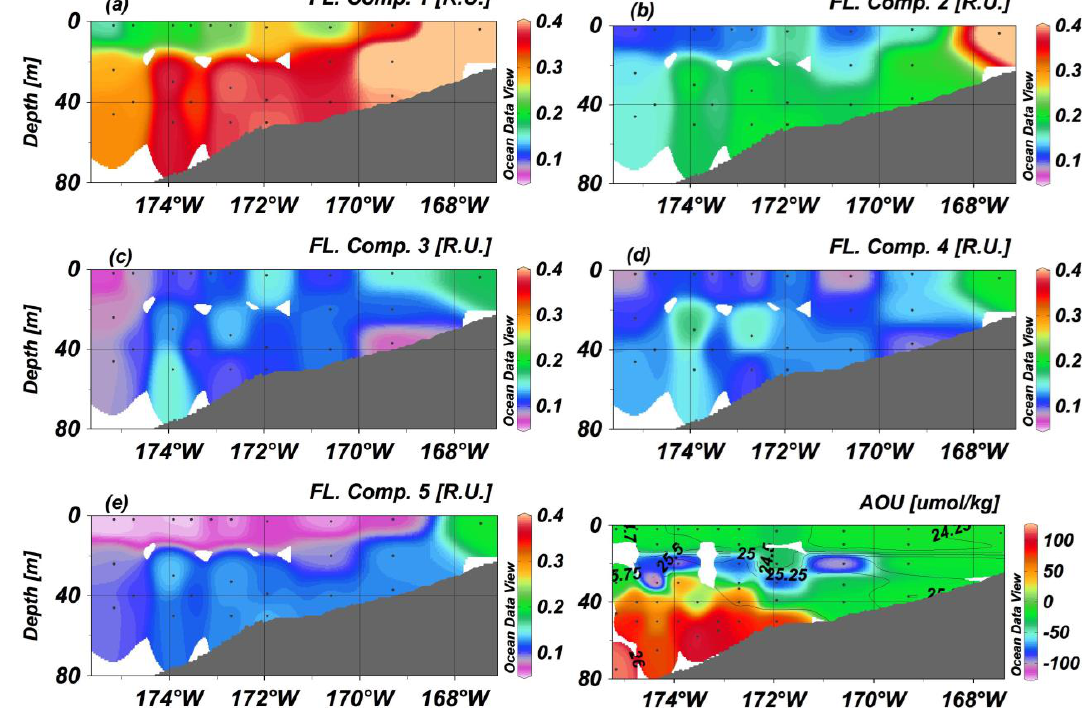
Figure 10. Vertical section of (a–e) fluorescence components C1–C5, and (f) AOU along the SL transect.